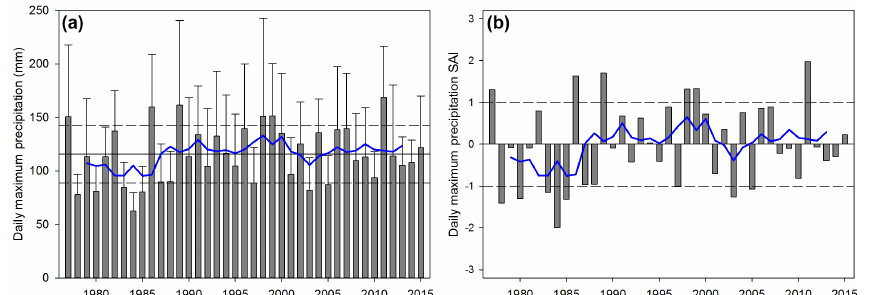
Figure 6. Mean maximum daily precipitation (a) and corresponding SAI (b) with error bars indicating 1 standard deviation from the mean for each station, along with the mean (solid) and 1 standard deviation from the mean (dashed line) for the daily rainfall analysis period; the blue solid line depicts the 5-year running average.